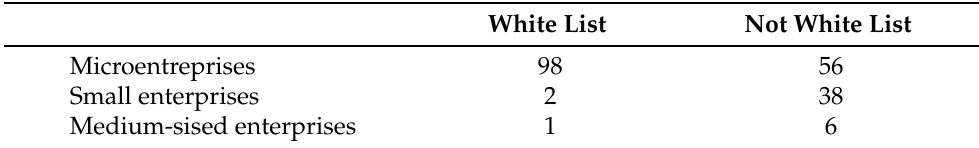
Table 3. Distribution of firms by size using the classification proposed by the Ministerial Decree 14 April 2005 (Value in %).